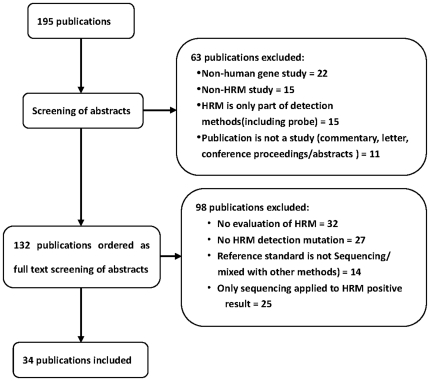
Flowchart for the selection of articles for meta-analysis.